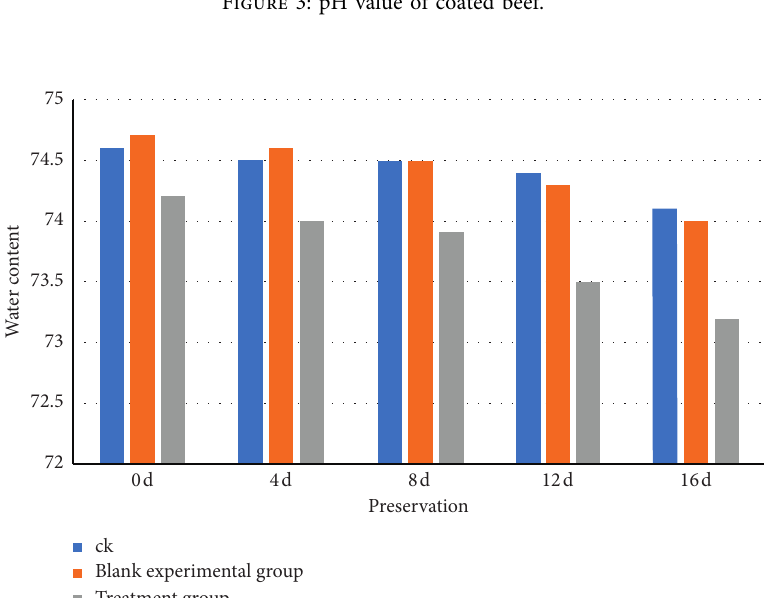
Figure 3: pH value of coated beef.